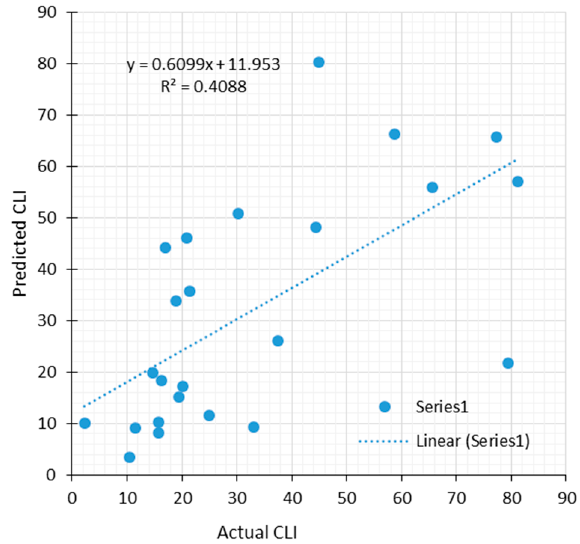
Figure 16. Relations between the actual and estimated CLI by ANN model 7 for testing.